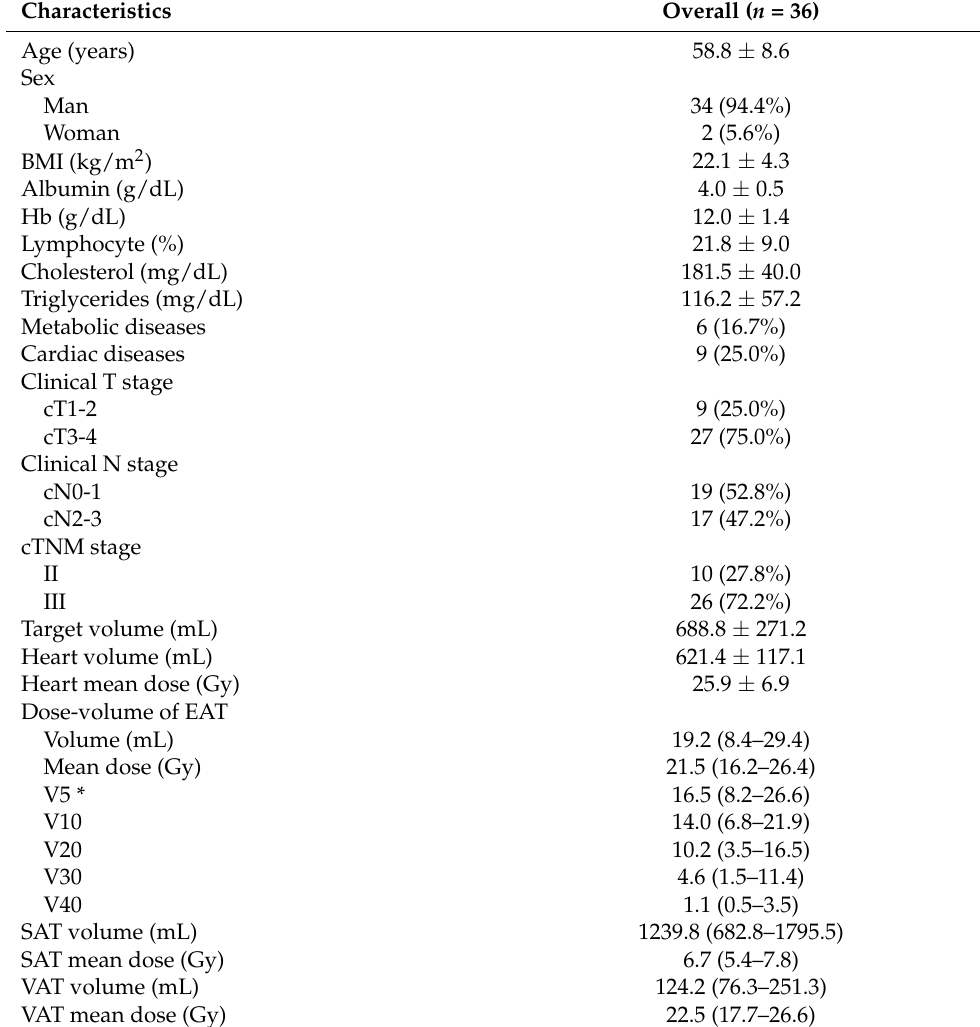
Table 1. Patient and tumor